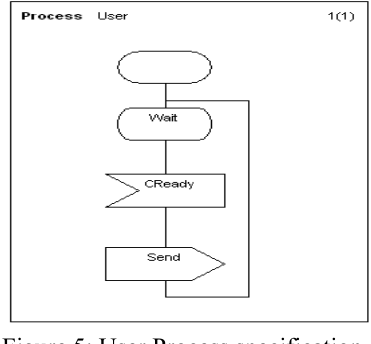
Figure 4: RESTMB block specification